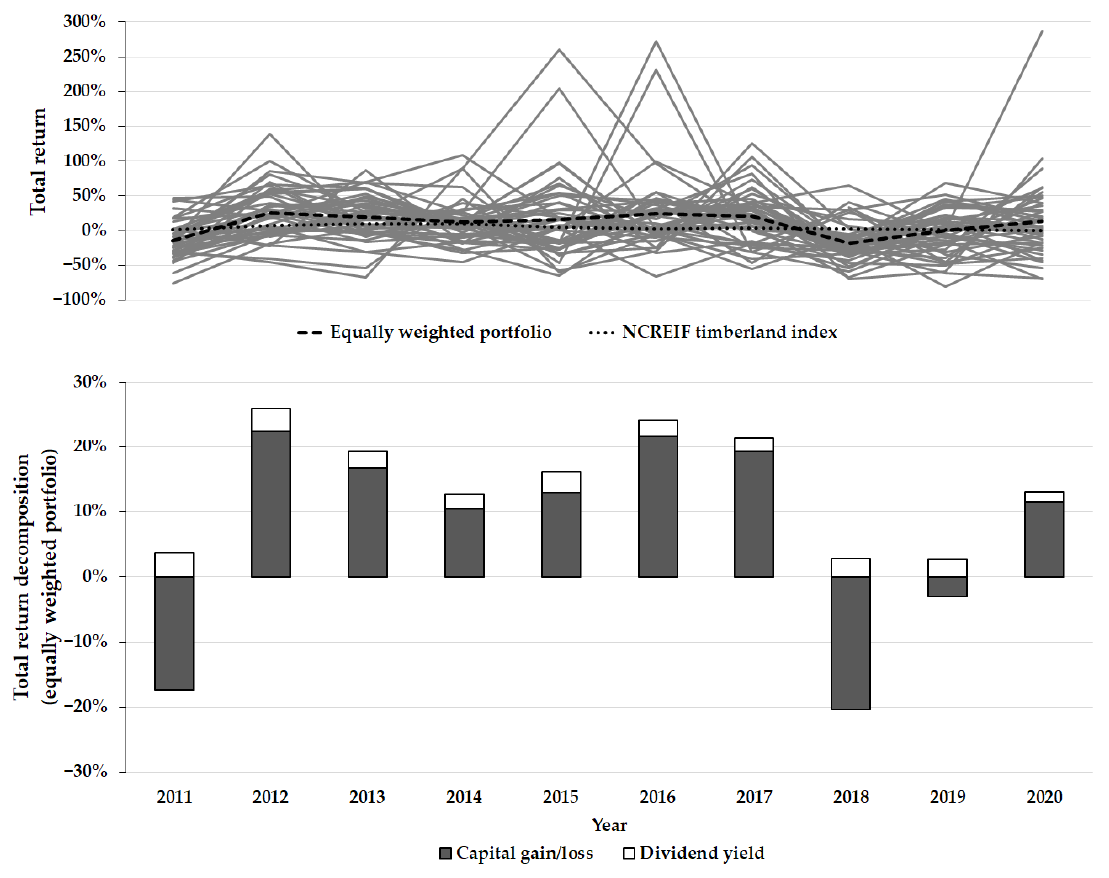
Figure 2. A 10-year decomposition of realized total return for an equally weighted portfolio of the observed stocks: variability of realized stock returns, corresponding averages, and the NCREIF tim- berland index performance (upper graph), and portfolio capital gains and dividend yield dynamics (lower graph).